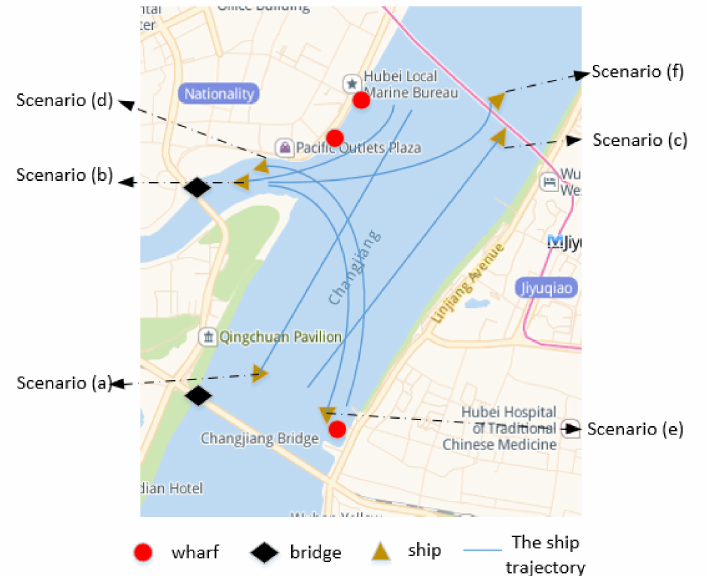
Figure 10. Schematic diagram of ship navigation traffic scene. Scenario (a): The ship enters the intersection area from the lower reaches of the Yangtze River, and the ship goes straight up. Scenario (b): The ship enters the intersection area from the lower reaches of the Yangtze River, and the ship turns right. Scenario (c): The ship enters the intersection area from the upper reaches of the Yangtze River, and the ship goes straight down. Scenario (d): The ship enters the intersection area from the upper reaches of the Yangtze River, and the ship turns left. Scenario (e): The ship enters the intersection area from the Han River, and the ship turns right, across the river, berthing. Scenario (f): The ship enters the intersection area from the Han River, and the ship turns